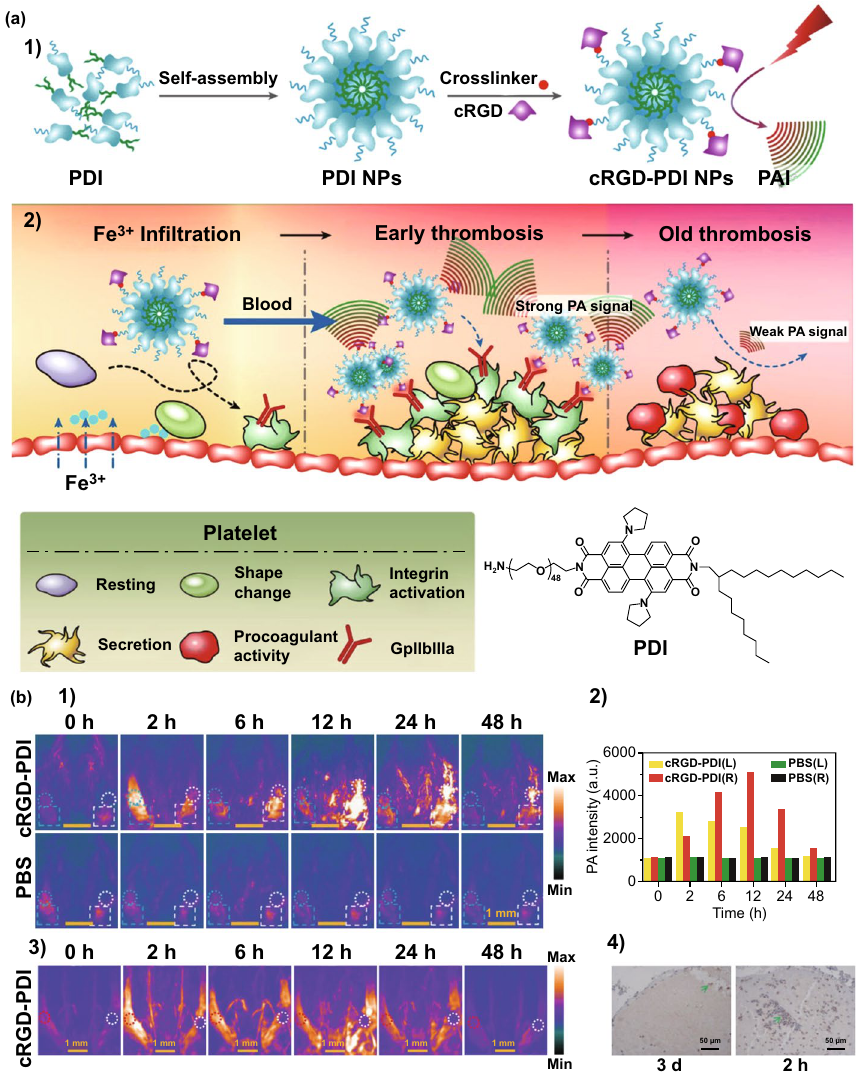
Fig. 3 a The preparation of the cRGD–PDI nanoparticles ( 1 ); the cRGD–PDI nanoparticles could accumulate in the early thrombus for diag- nosis by PAI ( 2 ). b PAI ( 1 ) and PA ( 2 ) intensity of the thrombus mouse model after different treatments (normal vessel, left vein; vessel with thrombus, right vein); ( 3 ) PAI of normal vessel (left vein) and old venous thrombus (right vein) after the administration of cRGD–PDI nanopar- ticles; ( 4 ) GPIIb/IIIa expression of old thrombus and early thrombus [53]. Copyright 2017 American Chemical